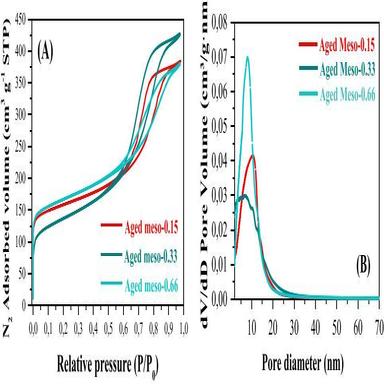
. (A) N2 isothermal adsorption-desorption and (B) BJH pore size distributions curves of hierarchical CHA-based zeolites synthetized with different CTAB amount.